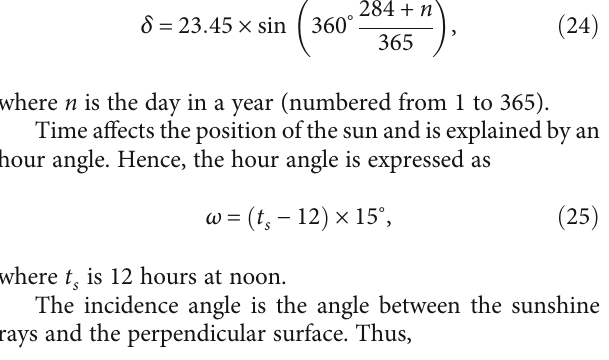
Figure 12 re fl ects the annual global solar irradiation. The